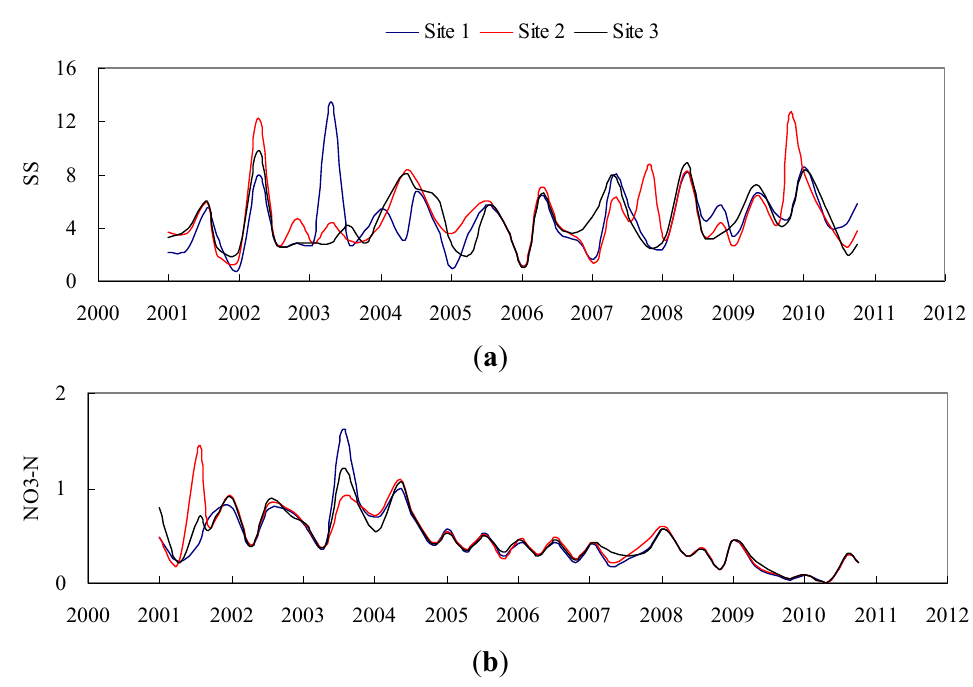
-N during 2001 and 2010 (unit: 3